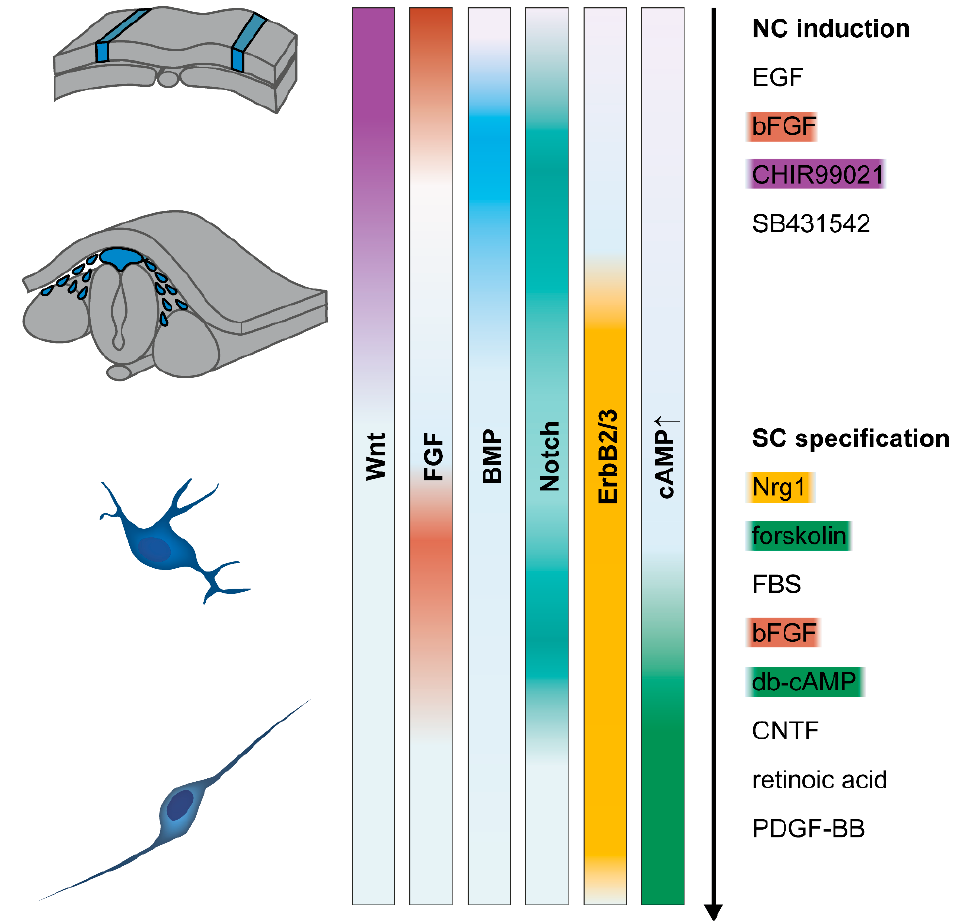
Figure 2. Major signaling pathways known to be involved in Schwann cell development. ( Left ): drawings schematically depict the major stages of Schwann cell (SC) development: neural crest (NC) formation, neural crest cell migration, Schwann cell precursor formation, and Schwann cell differentiation and maturation (from top to bottom). ( Middle ): color gradients indicate the developmental phases in which the indicated signaling pathways are known to be important. ( Right ): lists of some of the molecules frequently used for in vitro differentiation, assigned to the neural crest induction phase and Schwann cell specification phase. Color codes of the individual molecules in the right part match the corresponding activated pathways depicted in the middle.